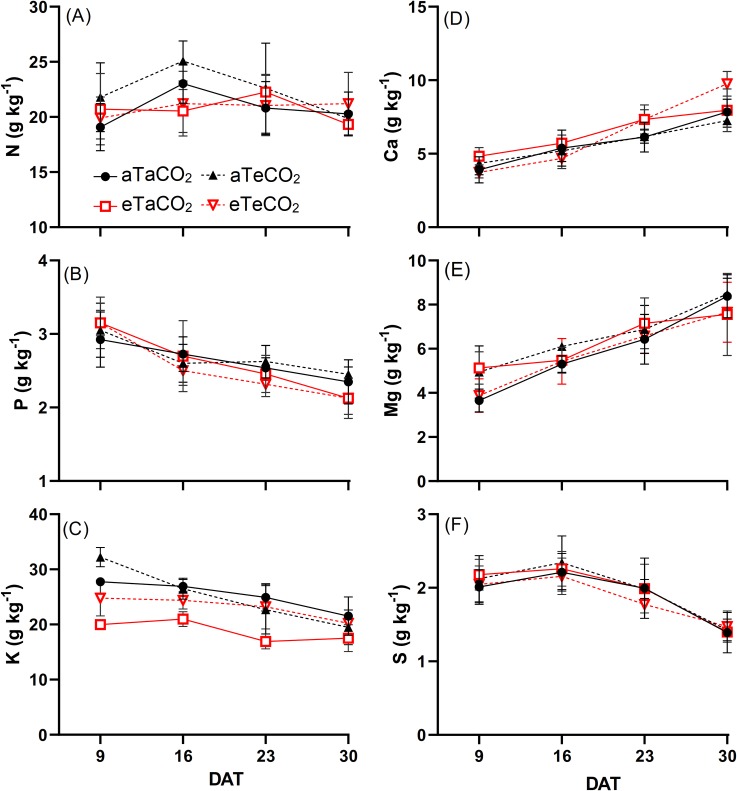
N (A), P (B), K (C), Ca (D), Mg (E) and S (F) content of P. maximum shoot during the experiment at 9, 16, 23 and 30 days after treatments (DAT). Treatments: aTaCO2 (ambient temperature and ambient [CO2]), eTaCO2 (2°C above ambient temperature and ambient [CO2]), aTeCO2 (ambient temperature and 200 ppm above ambient [CO2]), and eTeCO2 (2°C above ambient temperature and 200 ppm above ambient [CO2]). Bars show means and SE of four replicates.